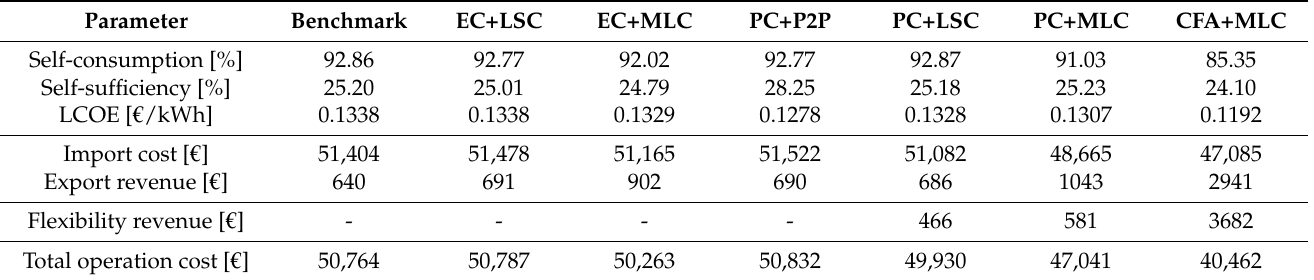
Table 3. Summary of simulation results with 2021 Nord Pool Spot